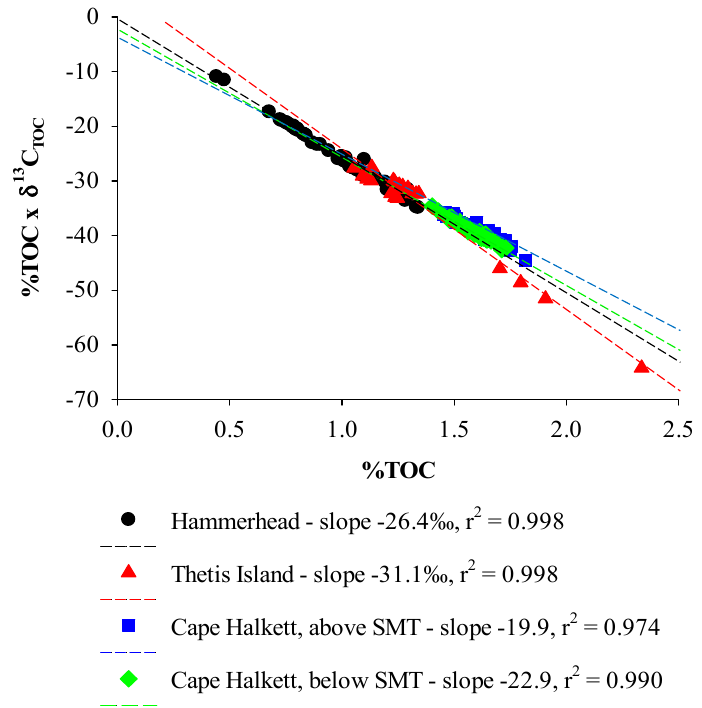
Figure 6. Plot of measured δ 13 C TOC × %TOC concentrations vs. %TOC concentrations in sediment cores collected along the North Slope of Alaska on the Beaufort Sea. Data are grouped into four data sets: Hammerhead Nearshore and Offshore; Thetis Island; Cape Halkett above and below the SMT (Figure 1). The slope of the linear fit to each data set is presented below the plot (Equation (4)).